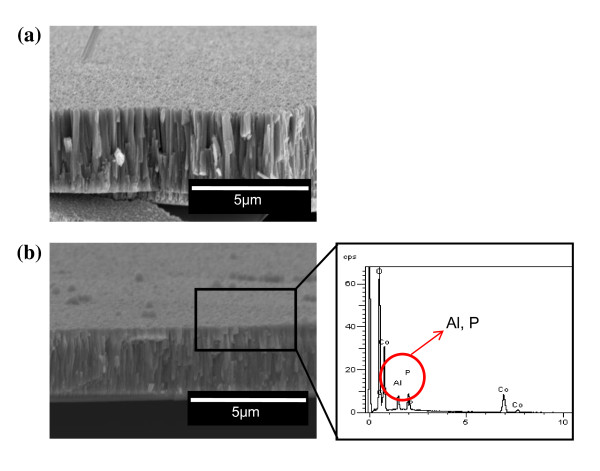
SEM images of (a) Pristine and (b) AlPO4-coated LiCoO2 thin films. The EDS peak of the coating layer is shown on the right.